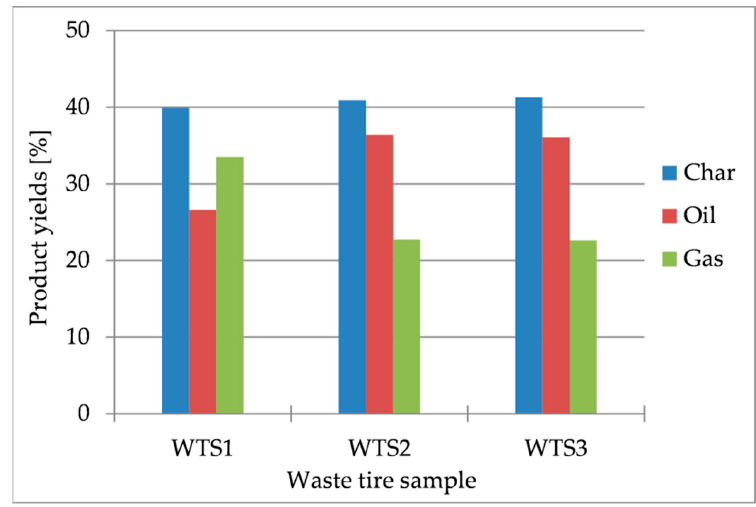
Figure 2. The share of pyrolysis products in relation to the size of the granules.